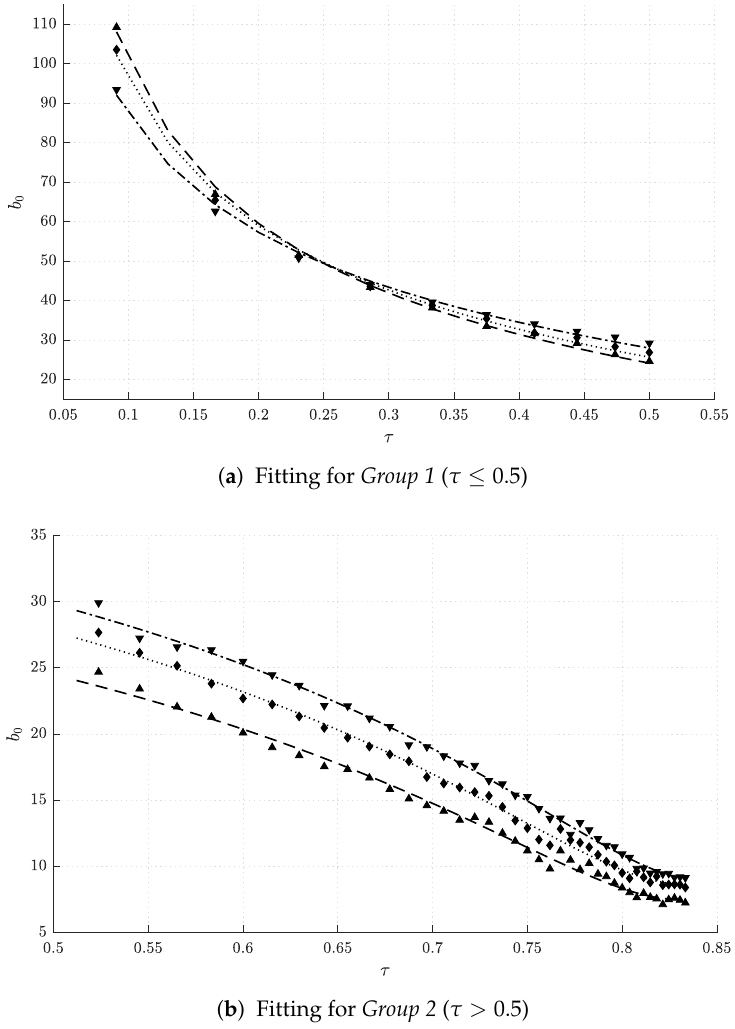
Figure 9. Tuning for nominal values of the LADRC critical gain. Markers indicate the optimal solutions NS 1 ( (cid:78) ), MP ( (cid:7) ), NS 2 ( (cid:72) ). Lines are the fitting functions for robustness levels ε low ( −− ), ε med ( · · · ), ε high (- ·